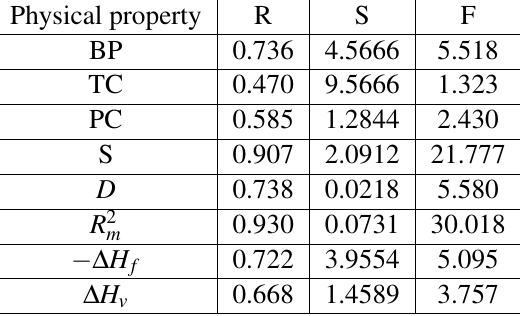
Table 10 Statistical parameters for the QSPR model